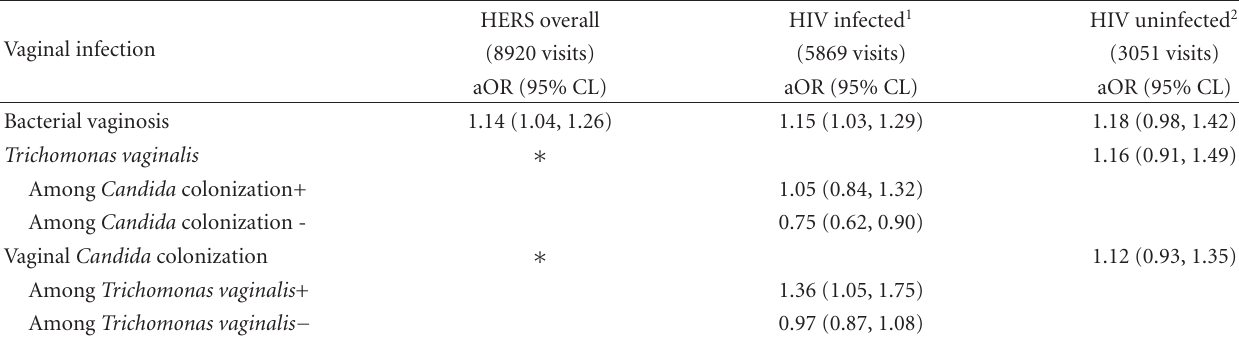
Table 2: Odds ratios for prevalent human papillomavirus among all HERS women and by HIV